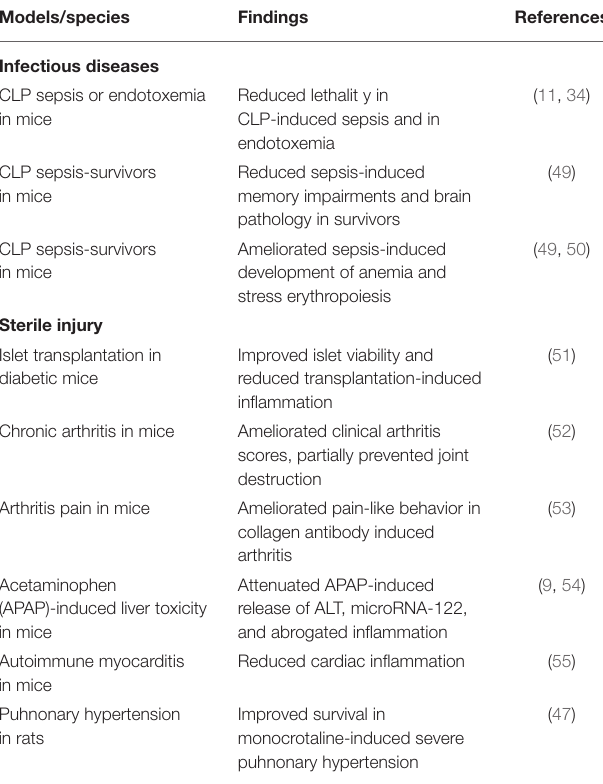
TABLE 2 | Summary of efficacy of anti-HMGB1 m2G7 in HMGB1-driven inflammatory diseases.